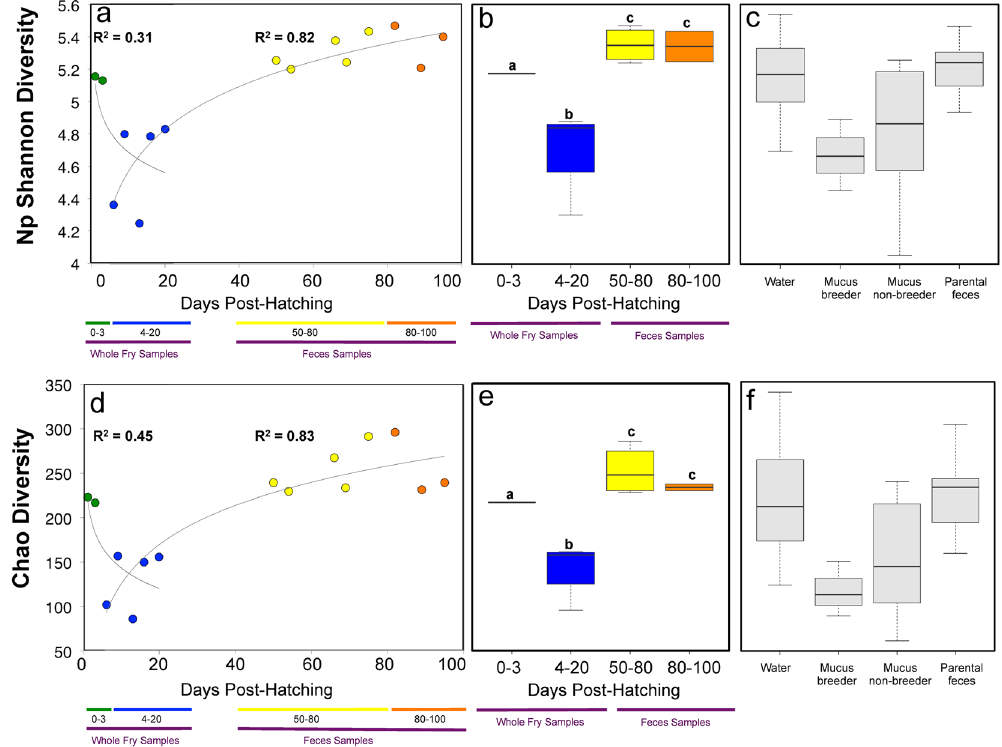
Figure 1. Alpha diversity in whole larvae microbiota significantly decreases between 0–3 and 4–20 DPH, but significantly increases from 4–20 to 50–80 and 80–100 DPH. Non-parametric Shannon (np Shannon) diversity indexes of whole larvae and fry feces microbiota are represented through time in ( a ) (in a scatter plot) and ( b ) (in a boxplot, including significance letters of t-tests at p-value threshold of 0.05). The np Shannon diversity of other microbial niches is represented in ( c ). Chao diversity indexes of whole larvae and fry feces microbiota are represented through time in ( d ) (in a scatter plot) and ( e ) (in a boxplot, including significance letters of t-tests at p-value threshold of 0.05). The Chao diversity of other microbial niches is represented in ( f ). Note that the adult diet is not represented in this figure (neither in c nor f ), as only one sample was collected from this microbial niche. Green markers represent samples taken before mucus feeding (0–3 DPH), blue markers represent samples taken during mucus feeding (4–20 DPH), yellow markers represent samples taken early after mucus feeding (50–80 DPH), and orange markers represent sample taken later after mucus feeding (80–100 DPH). Data layouts in ( a and c ) are best explained by logarithmic type trendlines. In ( b and c ), y-axis labels are the same than in ( a ). In ( e and f ), y-axis labels are the same than in ( d ). Since contrasted patterns of diversity were observed between 0–3 DPH to 4–20 DPH (decrease) and 50–80 DPH to 80–100 DPH (increase), the graphs in a and d are composites of two separate graphs that were merged together, to better illustrate the contrasted patterns from early to later developmental stages. The composite graphs in ( a and d ) were: one diversity scatter plot from 0–3 to 4–20 DPH, and another diversity scatter plot from 4–20 DPH to 50–80 and 80–100 DPH. The logarithmic trendlines were plotted independently on each composite graphs, before